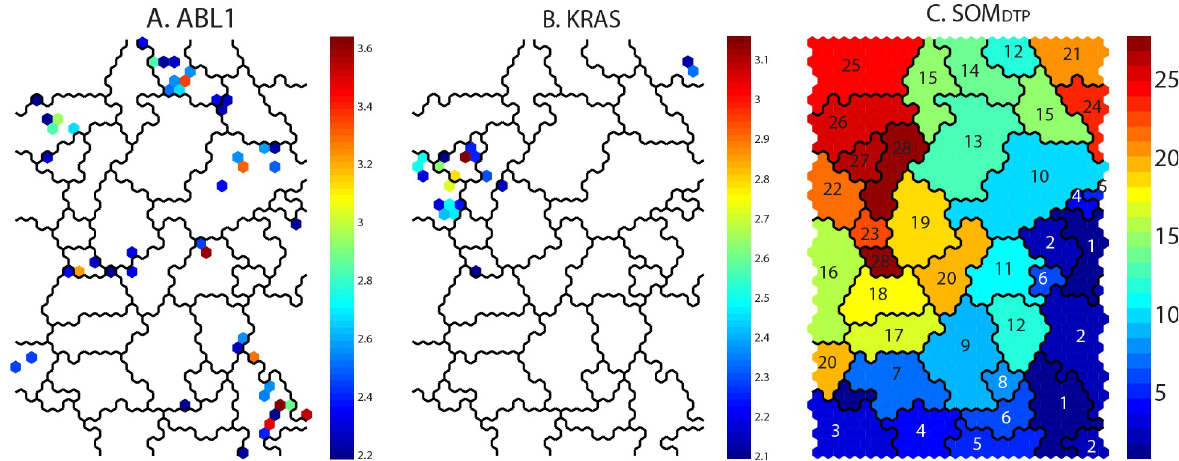
Fig 4. Panels A and B display significant chemosensitive SOM DTP nodes (projected as their t-statistic from a Student’s t-test; blue:least, red: most significant) for tumor cell lines with defective ABL1 and KRAS , respectively. Panel C displays the 28 SOM DTP